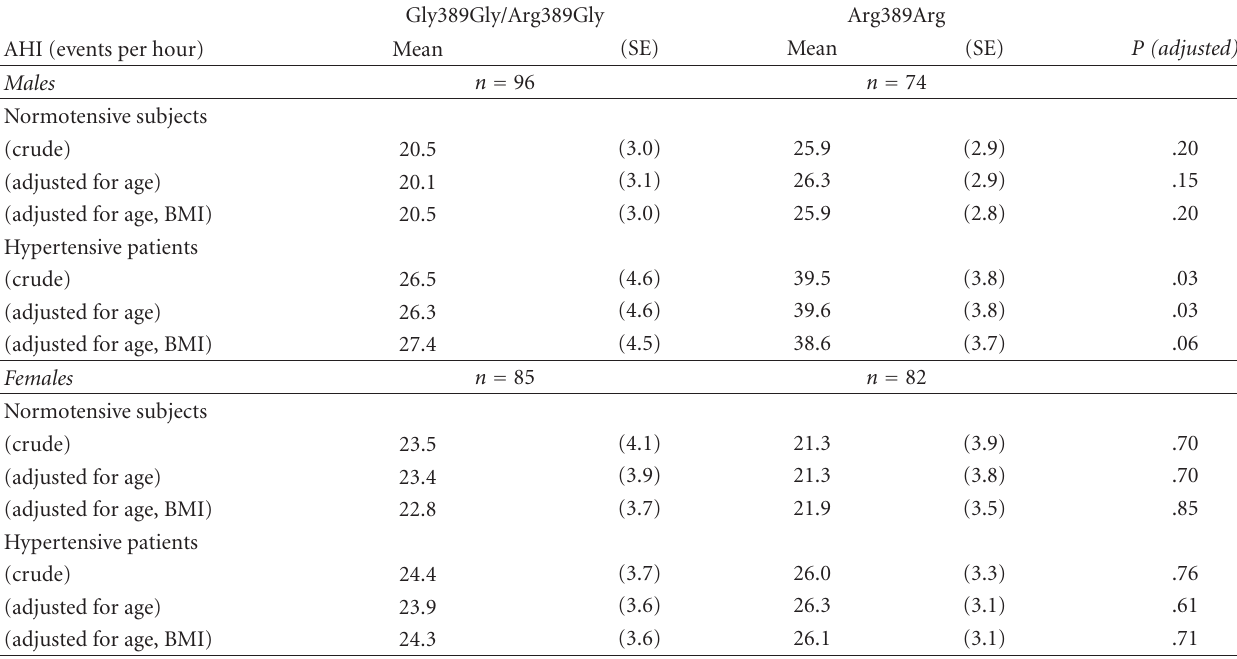
Table 4: Di ff erences in AHI between male and female carriers of the Arg389Gly genotypes of the Beta-1 adrenergic gene. Gly389Gly/Arg389Gly Arg389Arg